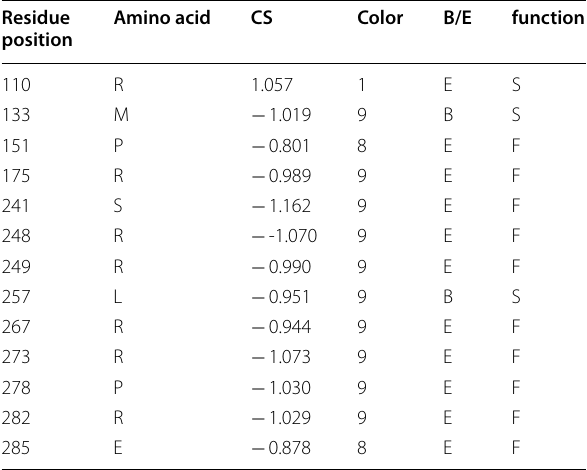
Table 4 Summary of amino acids (conservation profile) in that Table 6 Functional domains and their position in p53 corresponds to region with high-risk nsSNPs. CS: conservation score, color (6–9 conserved, 5 average and 1–4 variable); = = = (s): predicted structural site; (f): predicted functional site